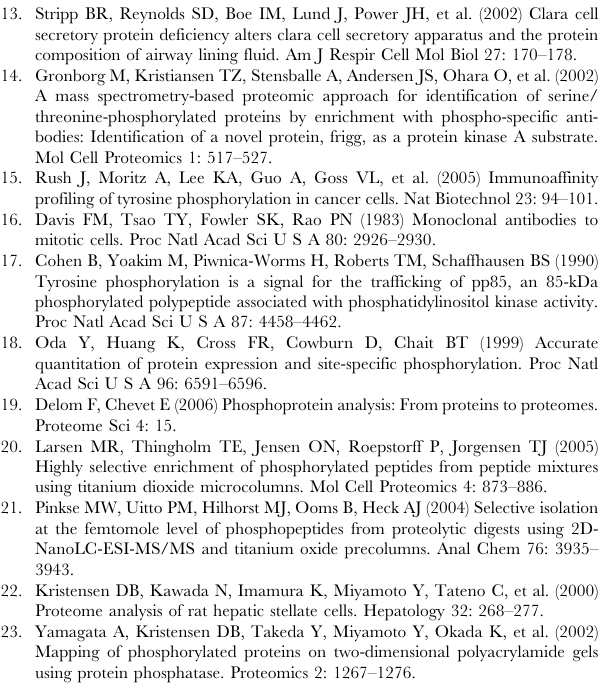
Table S1 Summary of sequence specific phosphoresidues of identified proteins and bioinformatic prediction of kinases involved. Table S2 Monoclonal antibodies and their properties. Table S3 GO annotations of identified